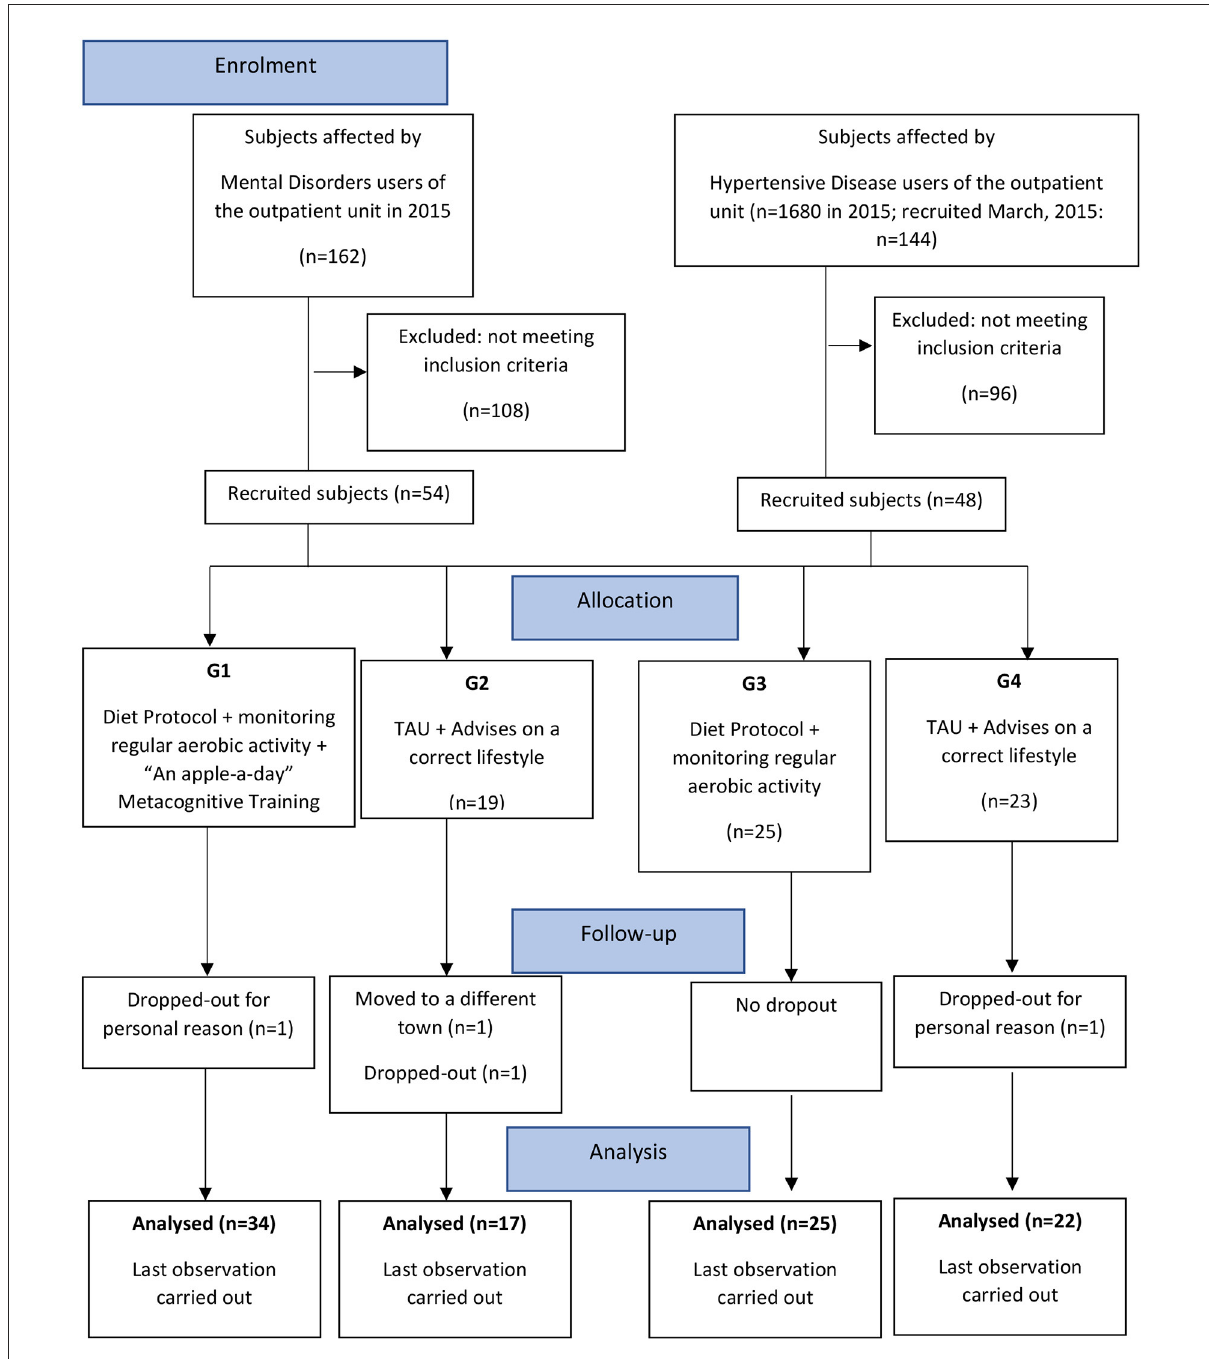
FIGURE1 Flow of subjects through the 4-arm study.